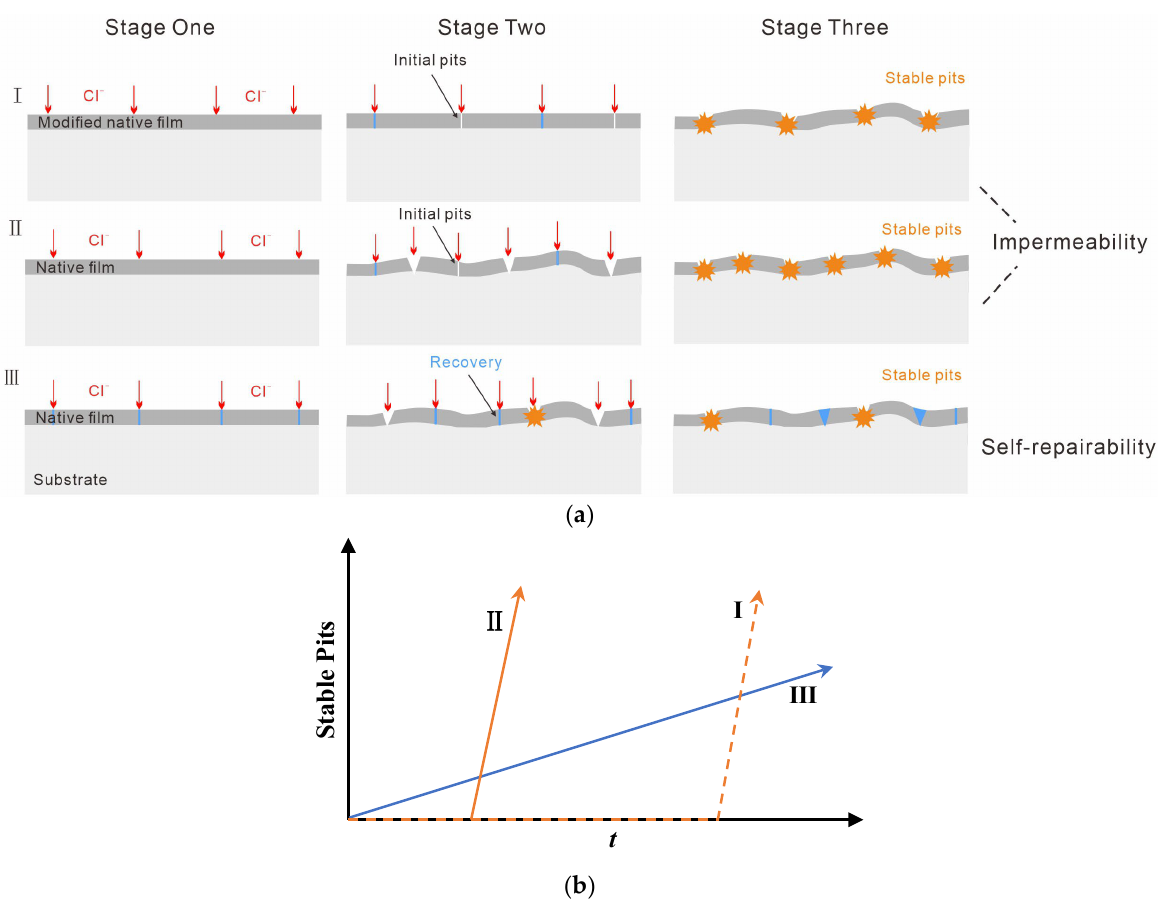
Figure 1. ( a ) Illustration of the determining dominant factors comparing the development of pitting: I, FE alloy with a typical impermeability-dominated corrosion resistance exhibits the least number of metastable pits at the initial stage due to the modified oxide film; II, Bare alloy with impermeability-dominated corrosion resistance, for which the native film can offer protection for a period; III, Bare alloy with a self-repairability-dominated corrosion resistance, in which metastable pitting occurs early but the stabilization of pits needs a long period of time. ( b ) The development of stable pits for each protection mechanism.